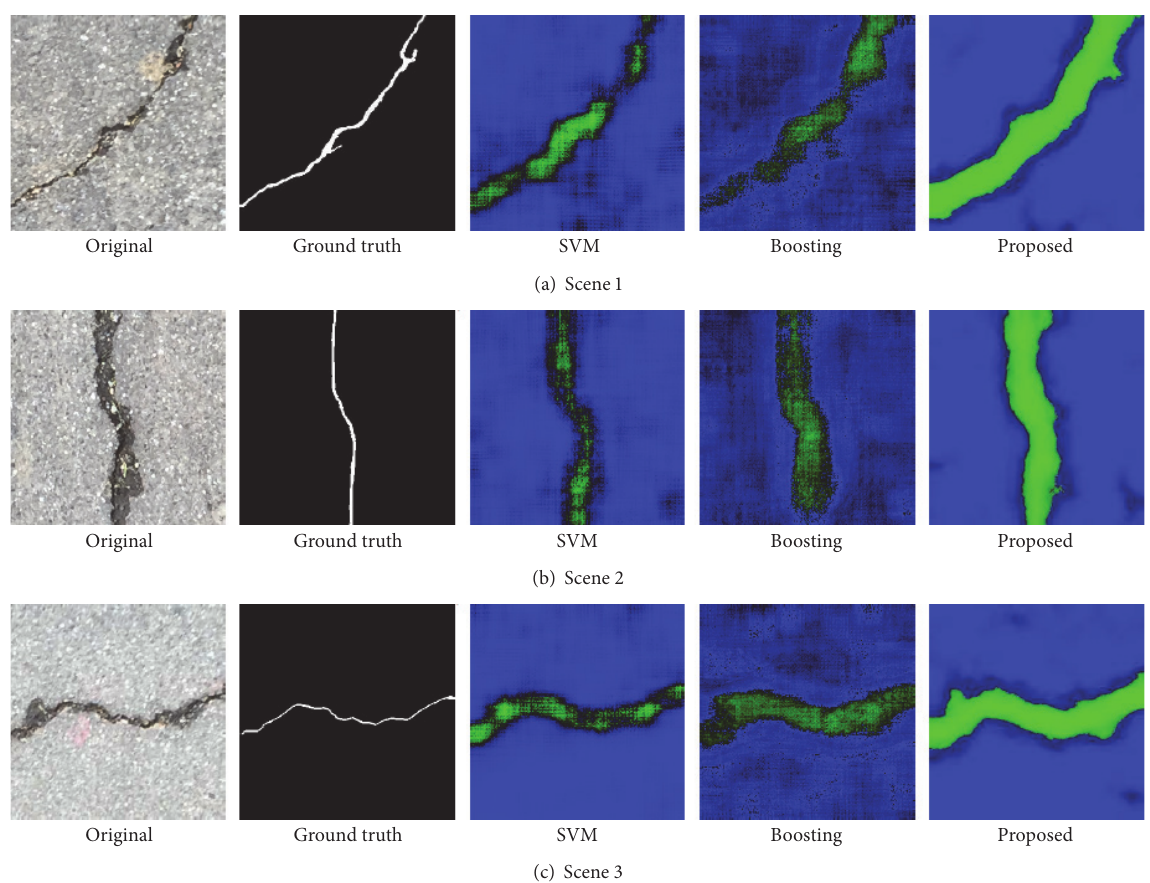
Figure 11: Probability